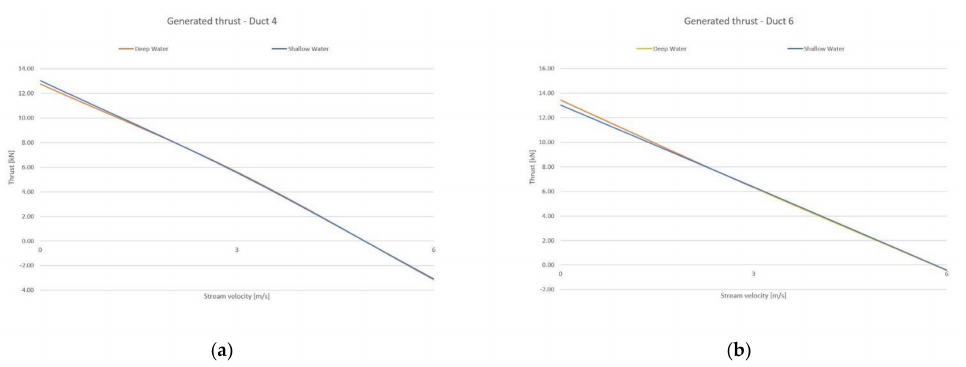
Figure 14. Impact curves of propulsion units. ( a ) Generated thrust of the propeller with Duct 4 depending on the water depth; ( b ) generated thrust of propeller with Duct 6 depending on the water